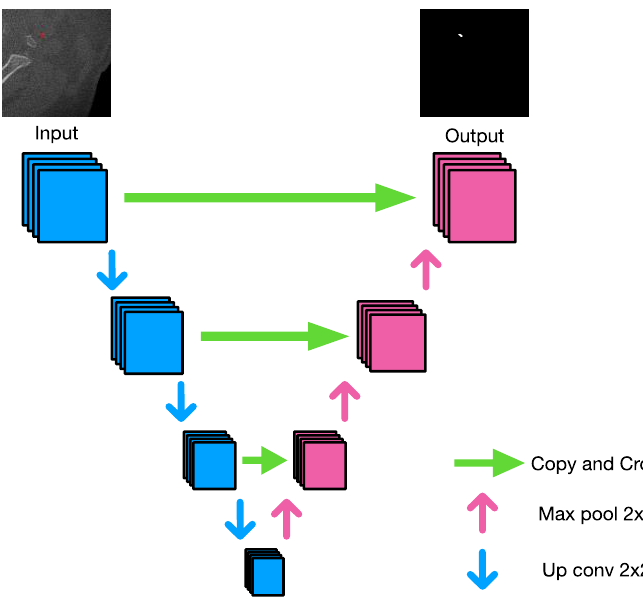
Figure 5. U-Net architecture.